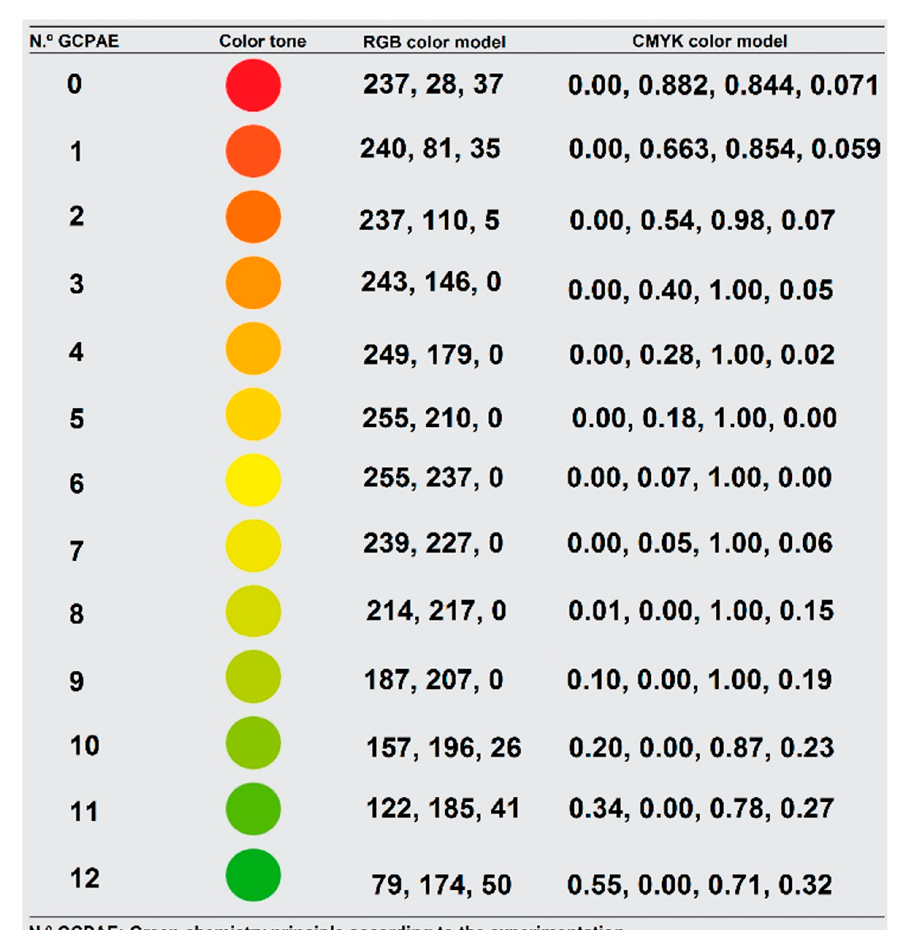
Figure 16. Traffic light metric to assess the green approach. Adapted from Ref. [22].